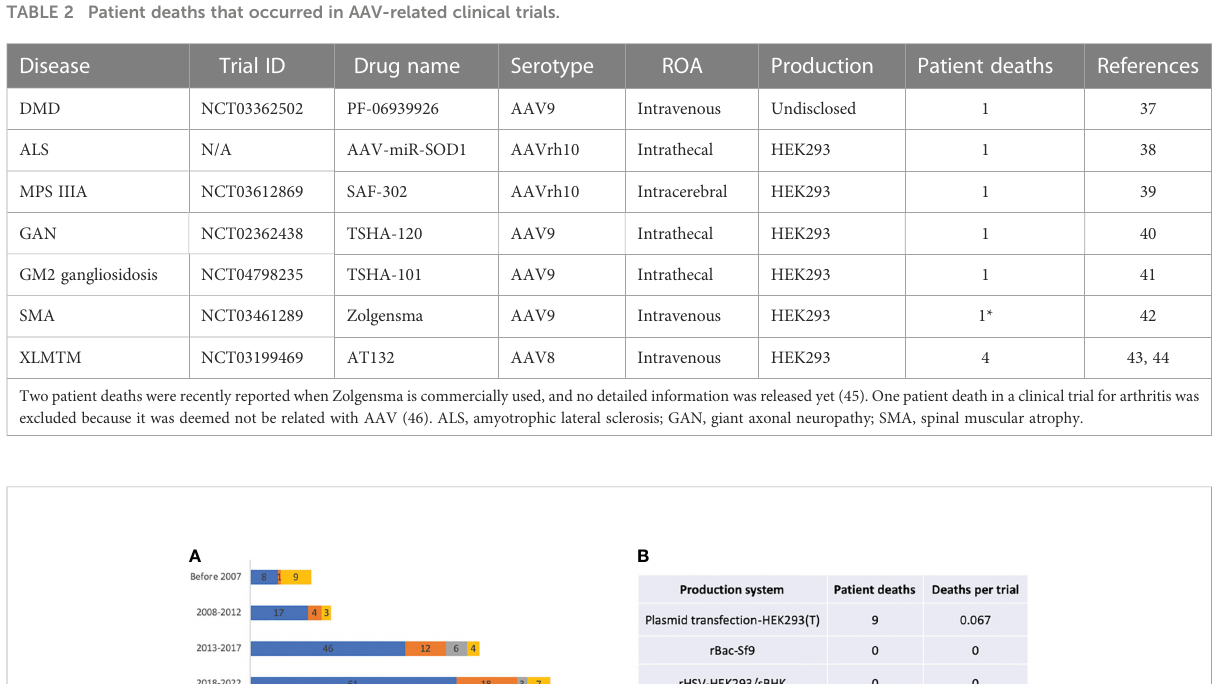
TABLE 2 Patient deaths that occurred in AAV-related clinical trials.